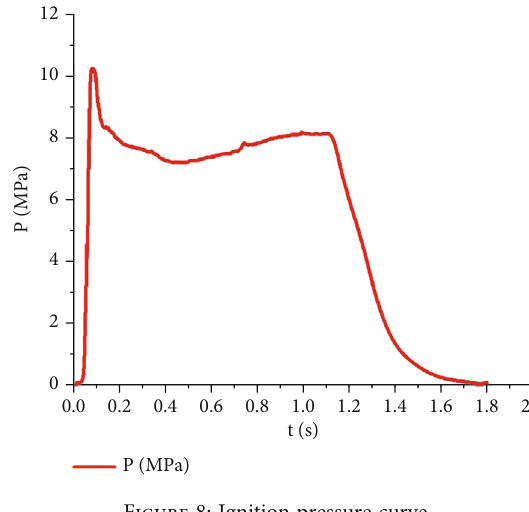
Figure 8: Ignition pressure curve.